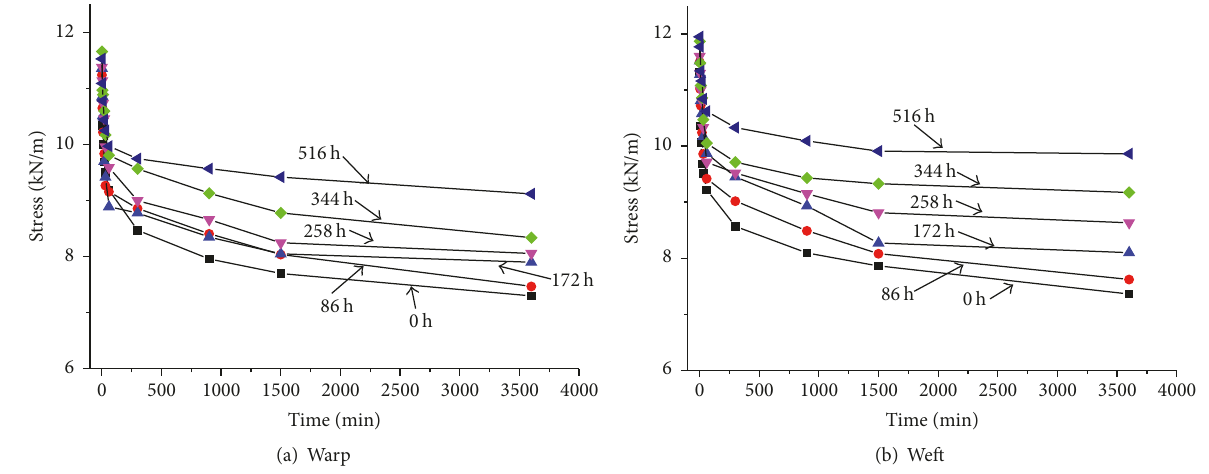
Figure 6: Stress-relaxation behaviors after different aging